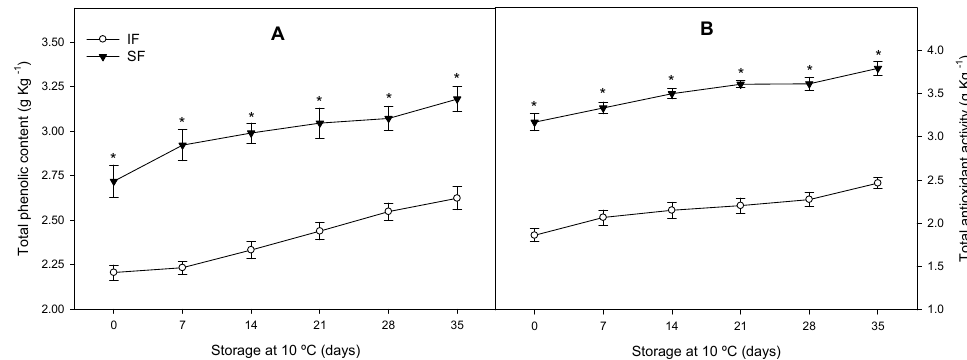
Figure 1. Effect of standard fertigation (SF) and intensive fertigation (IF) on the total phenolic content ( A ) and total antioxidant activity ( B ) in lemon fruits stored for 35 days at 10 °C. Asterisks (*) represent significant differences between lemon fruits cultivated with IF and those with SF at p < 0.05.